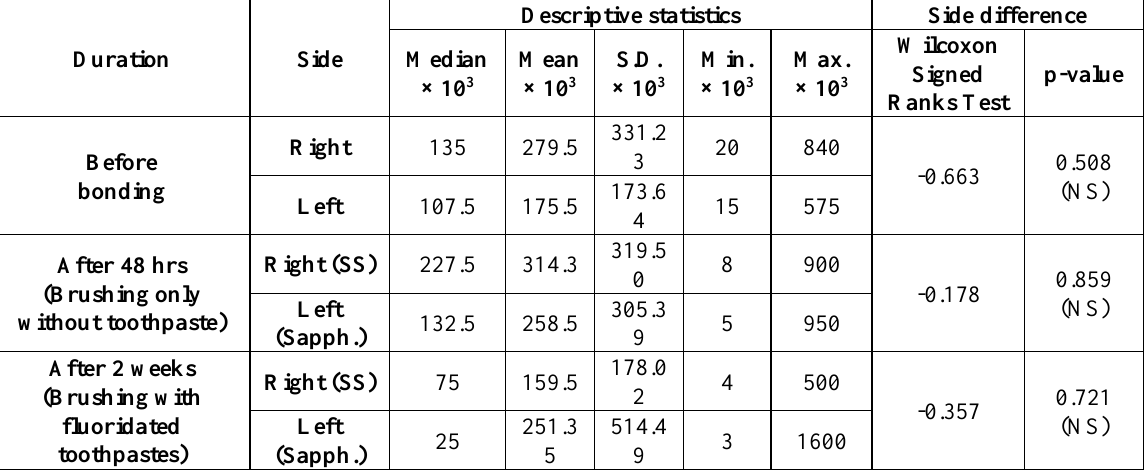
Table 1: Descriptive statistics and side difference of bacterial count before bonding, after 48 hrs of using tooth brush only, and after 2 weeks of using conventional fluoridated